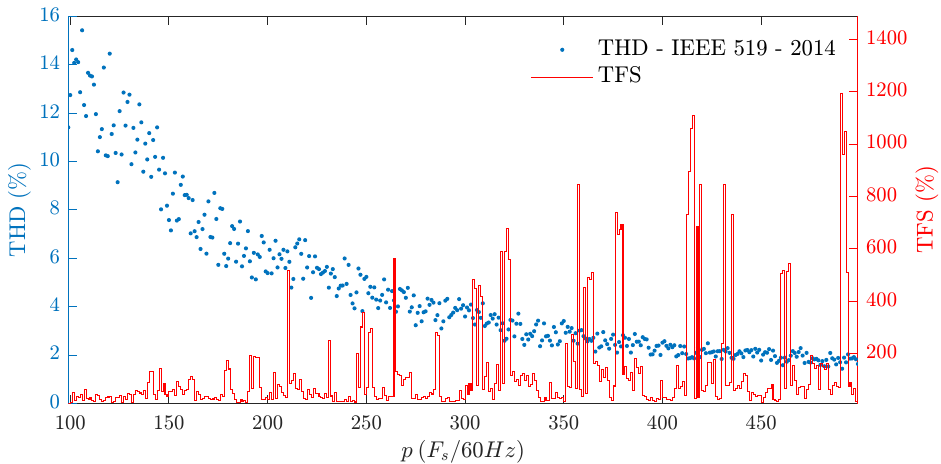
Figure 12. Sampling frequency effect in FCS-MPC using the cost function (11): THD and TFS. However, TFS presents a highly nonlinear behavior with some high peaks, showing that the switching frequency spread profile is highly dependent on the choice of the sampling